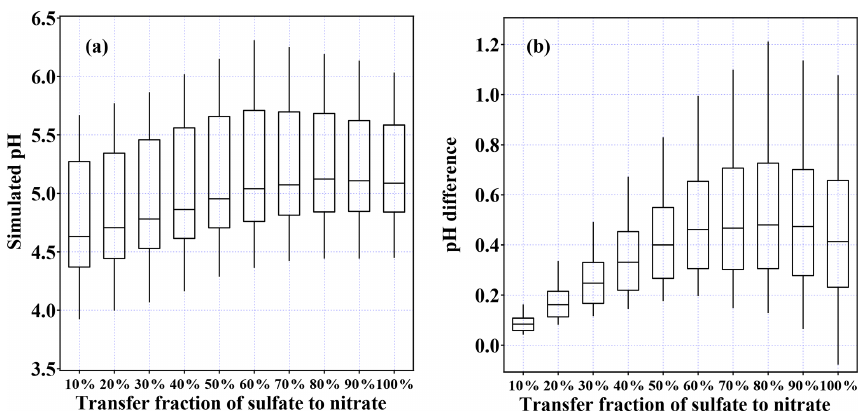
Figure 7. Box plot of (a) simulated pH using the setting of the sensitivity test as well as (b) pH difference between the simulated pH from the transferred data and the original observation data (only data with sufficient aerosol liquid water content (above 5µgm − 3 ) during the pollution period were